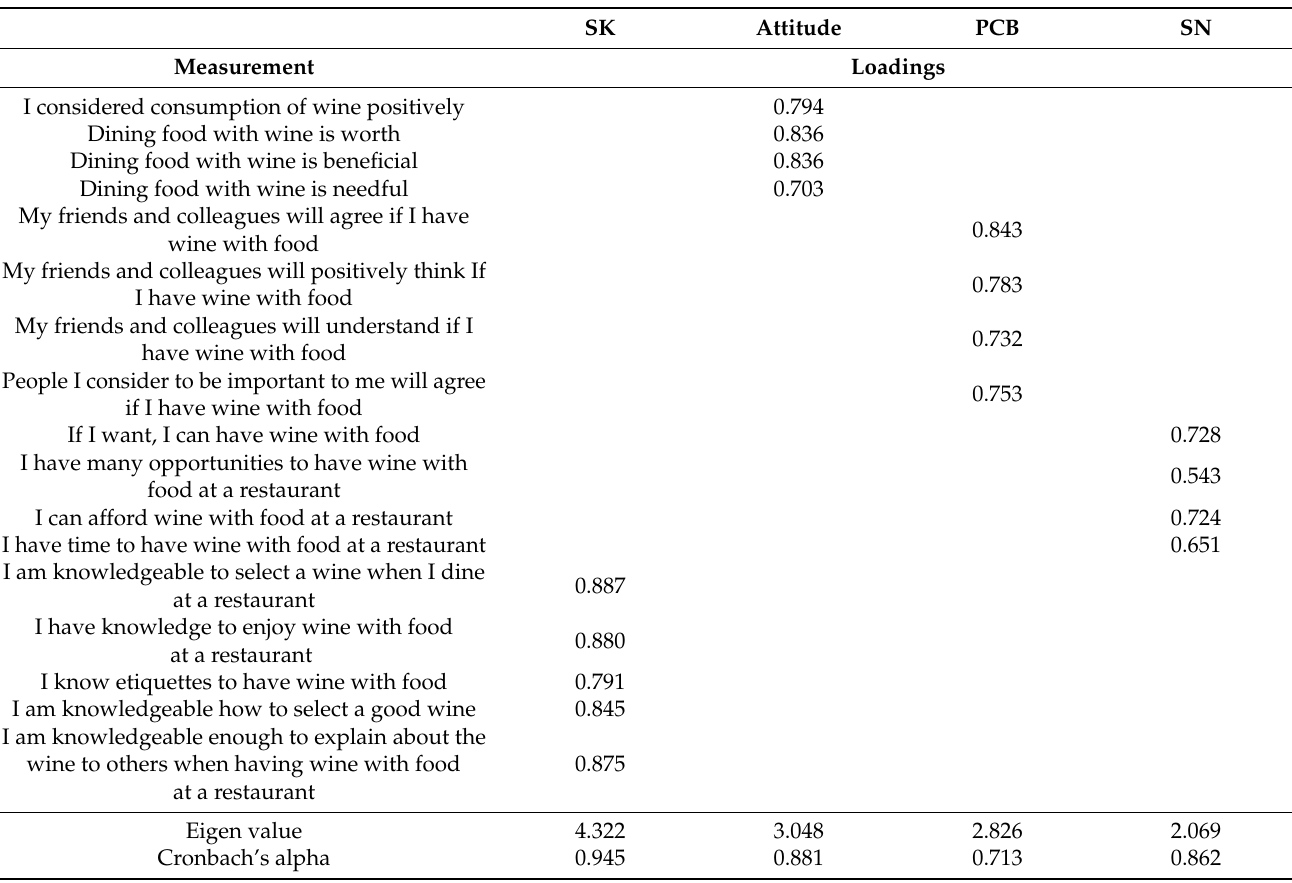
Table 1. Results of Exploratory Factor